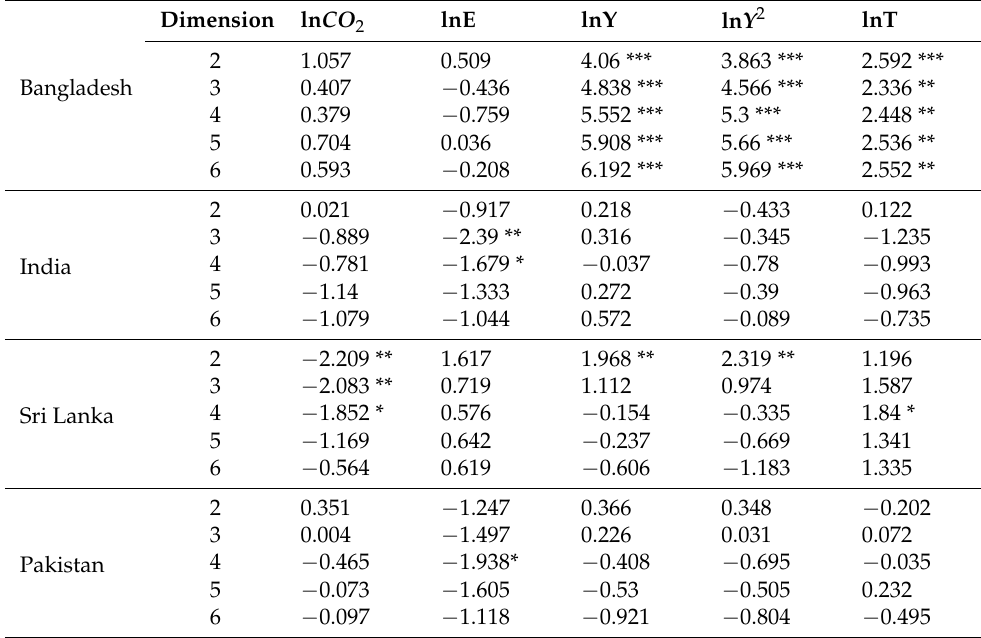
Table A2. The Brock, Dechert, and Scheinkman (BDS) tests results.